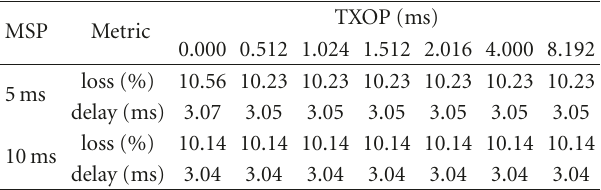
Table 3: E ff ects of varying TXOP on the RT tra ffi c, for 20 RT stations—MSP = 5 ms and 10ms.